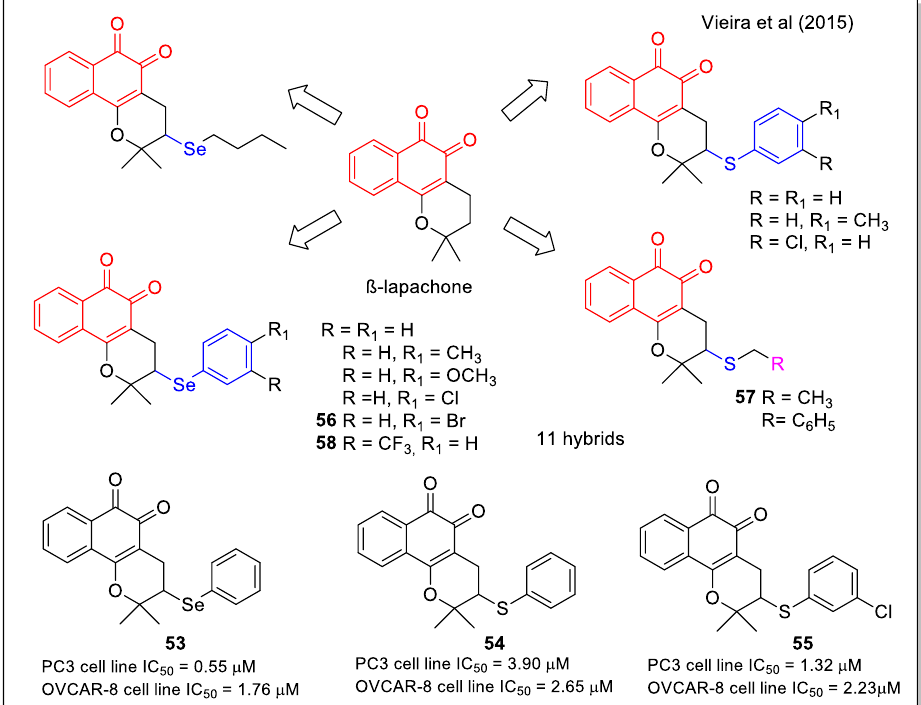
Figure 22. β -Lapachone-chalcogen (Se or S) hybrids as reported by Vieira et al. [63].